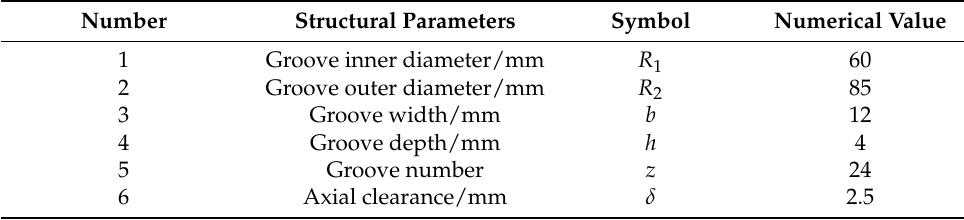
Figure 5. Computational domain of the first-stage liquid-sealing impeller. Table 1. Main structural parameters of the first-stage liquid-sealing impeller.